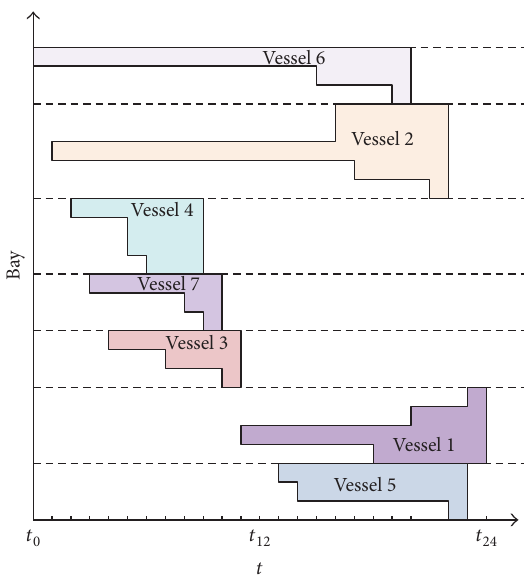
Figure 8: The piling state of containers belonging to 7 vessels when piling onto fixed area.